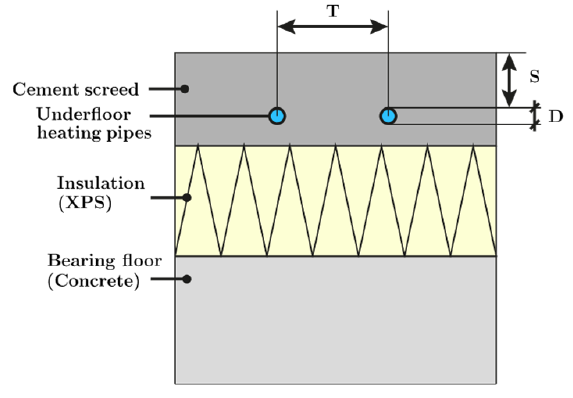
Figure 3. Illustration of a section of the underfloor heating system.